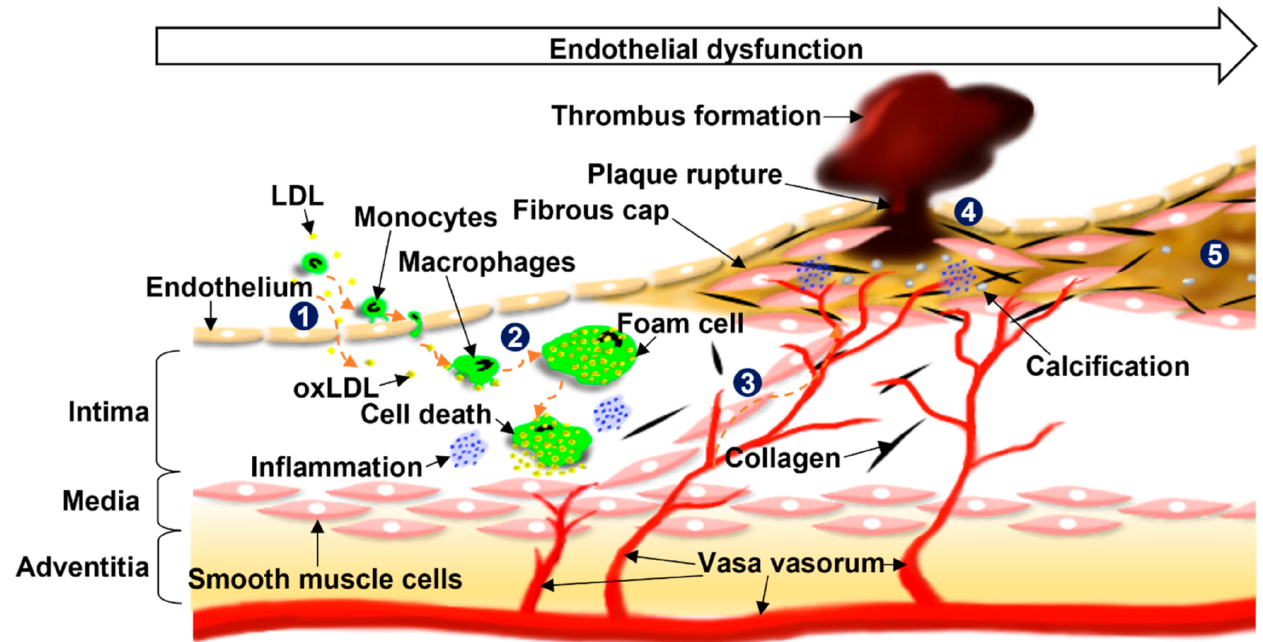
Figure 1. Development of atherosclerosis. (1) Dysfunction of endothelial cells (ECs) leads to migration of low-density lipoproteins (LDLs), resulting in the expression of monocyte adhesive molecules on the ECs and inflammation. (2) Monocytes transmigrate intima and differentiate to macrophages binding to oxidized LDL (oxLDL), which causes the formation of foam cells and cell death. Fatty streaks are developed and vasa vasorum begins to be built. An additional increase in foam cells and macrophage necrosis induces core of extracellular lipid and calcification of the plaque occurs. (3) Successive inflammation gives rise to the migration of smooth muscle cells with collagens from the media to the intima forming a fibrous cap. (4) Further accumulation of plaque and inflammation causes the thickness of the fibrous cap to be thin, and eventually, the plaque’s fibrous cap ruptures, forming thrombus. (5) Plaque stabilizes, resulting in a stenosed lumen area